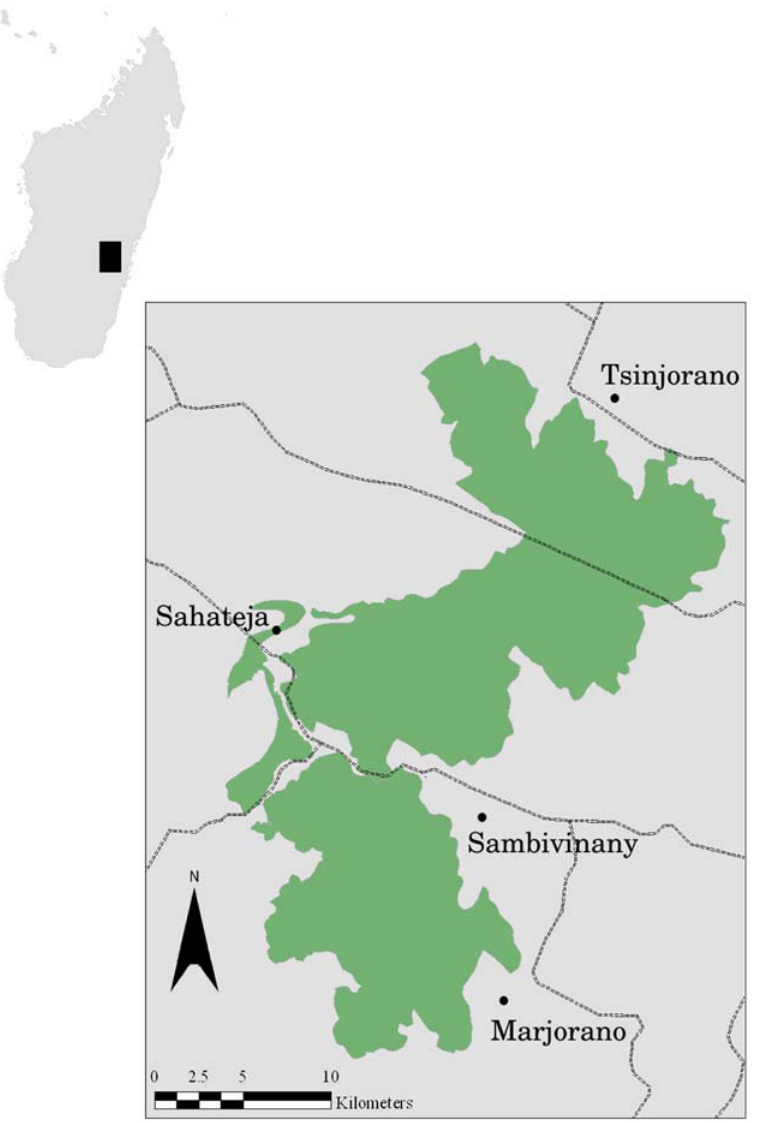
Figure 1. A map of the area around Ranomafana National Park showing the study villages and all roads. The the sole primary road between the RNP region and the major urban centers runs east-west through the center of the park near both Sahateja and Sambivinany.